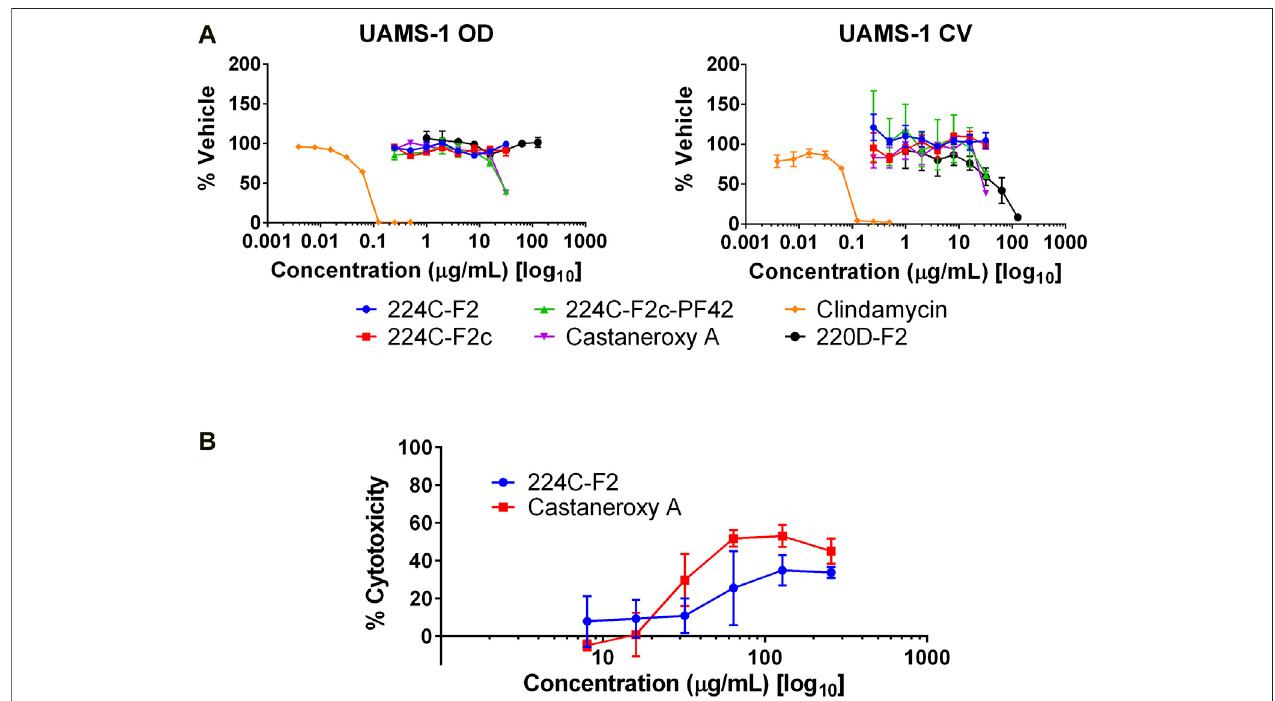
FIGURE 10 | Other effects of castaneroxy A ( 1 ). (A) Compound 1 and its parent fractions do not inhibit bio fi lm formation in UAMS-1. Clindamycin was used as a control to demonstrate bio fi lm inhibition due to growth inhibition. The left graph shows optical density (OD), indicating growth as a result of treatment; the right graph shows crystal violet (CV) stain density retained by bio fi lms after treatment as a measure of bio fi lm production. (B) Concentration response curves demonstrate modest cytotoxicity of 1 and 224C-F2 against human keratinocytes (HaCaT